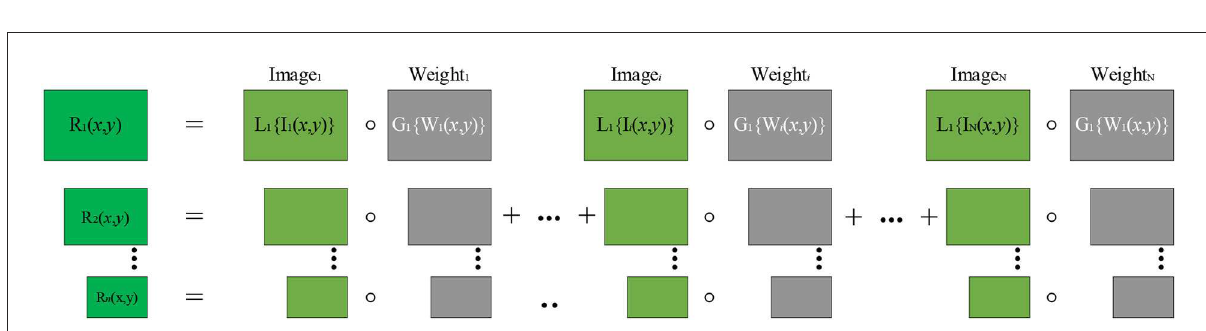
FIGURE4 General flow of multi-scale exposure fusion. I i ( x , y ) is an LDR image. W i ( x , y ) is a weighted mapping. The Laplacian pyramid is obtained by LDR image decomposition, and the weighted mapping decomposition obtains the Gaussian pyramid. R 1 ( x , y )–R n ( x , y ) is the resulting level of the Laplacian